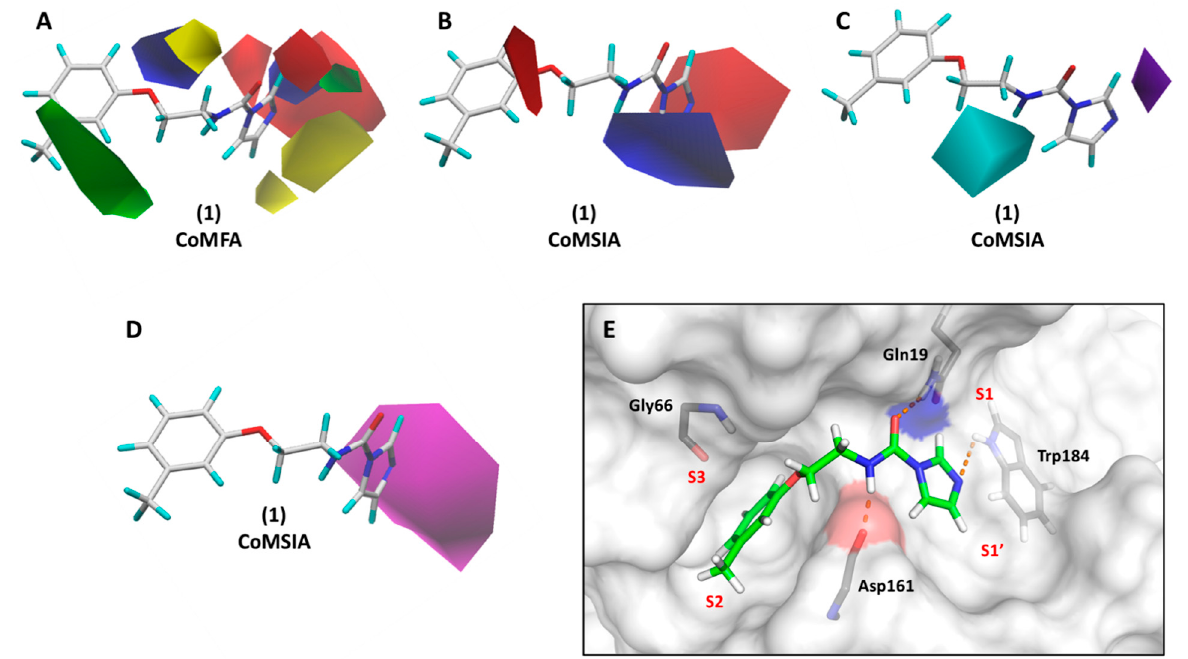
Figure 8. 3D StDev*Coeff CoMFA and CoMSIA contour maps for compound 1. ( A ) CoMFA steric and electrostatic contour maps; ( B ) CoMSIA electrostatic contour maps; ( C ) CoMSIA hydrogen-bond donor contour maps; ( D ) CoMSIA hydrogen-bond acceptor contour maps; ( E ) predicted binding conformation of compound 1. Compound 1 and cruzain binding site residues are depicted as sticks. Cruzain is shown as a surface, with Asp161 highlighted in red and Gln19 highlighted in blue. Hydrogen bonds are shown as dashed lines. Green and yellow plots: Bulky groups are favorable and unfavorable to activity, respectively. Blue and red contours: Positive and negative groups, respectively, are favorable to activity. Cyan and purple plots: Hydrogen bond donors are favorable and unfavorable to activity, respectively. Magenta: Hydrogen-bond acceptors are favorable to activity.